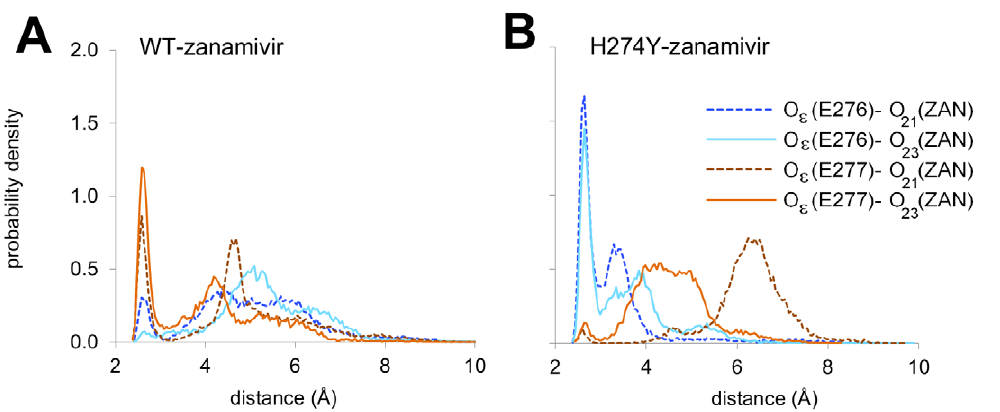
Figure 4. Differences in hydrogen bonding with the zanamivir tail in the H274Y mutant. Distribution of the average distance between the atoms O